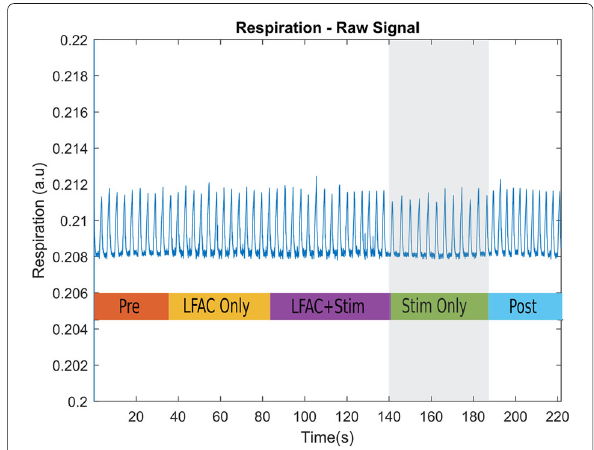
Fig. 3 Example of a raw respiration data set during experiment. Vagal stimulation alone occurred at approximately 140 seconds, shown as the shaded region. In this period, there is an evident increase in inter-breath interval and a slight decrease in amplitude. This